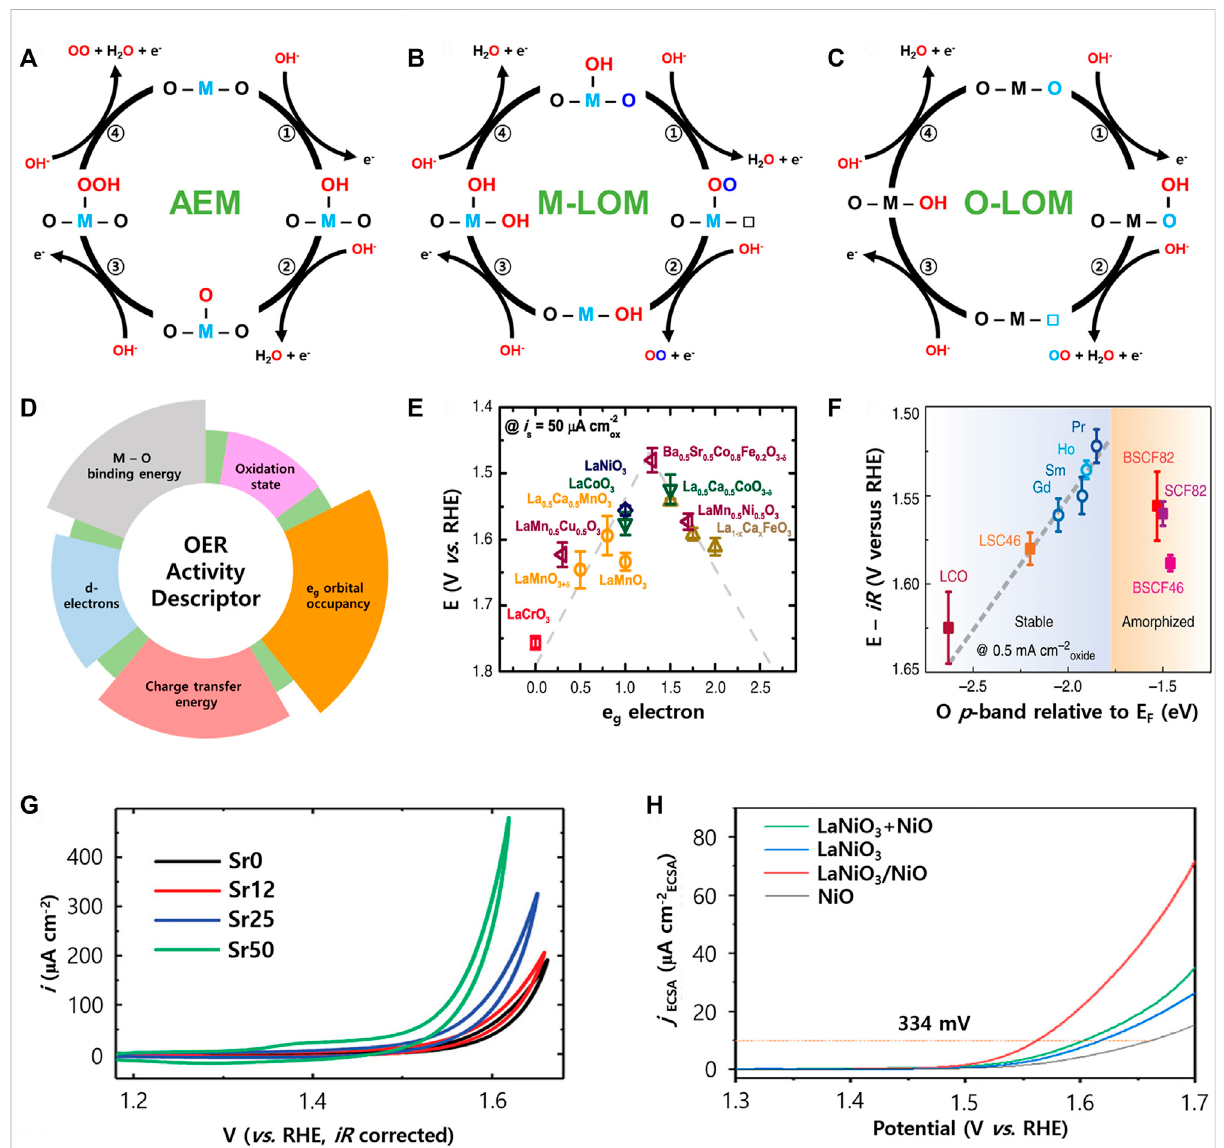
FIGURE 2 SchematicillustrationofOERmechanismsinvolving (A) AEM, (B) M-LOM,and (C) O-LOM. (D) VariousdescriptorsrelatedtotheperovskiteOER activity. (E) TherelationbetweentheOERactivityandthee g orbitaloccupancy,reproducedwithpermissionfrom(Suntivichetal.,2011). (F) Thetrend of the iR -corrected potential vs. the O p -band centre relative to E F (eV), reproduced with permission from (Grimaud et al., 2013). (G) Cyclic voltammetry data of LSNO fi lms normalized by the speci fi c area, reproduced with permission from (Liu et al., 2019). (H) LSV curves of various LaNiO 3 electrocatalysts normalized by ECSA, reproduced with permission from (Wei et al.,